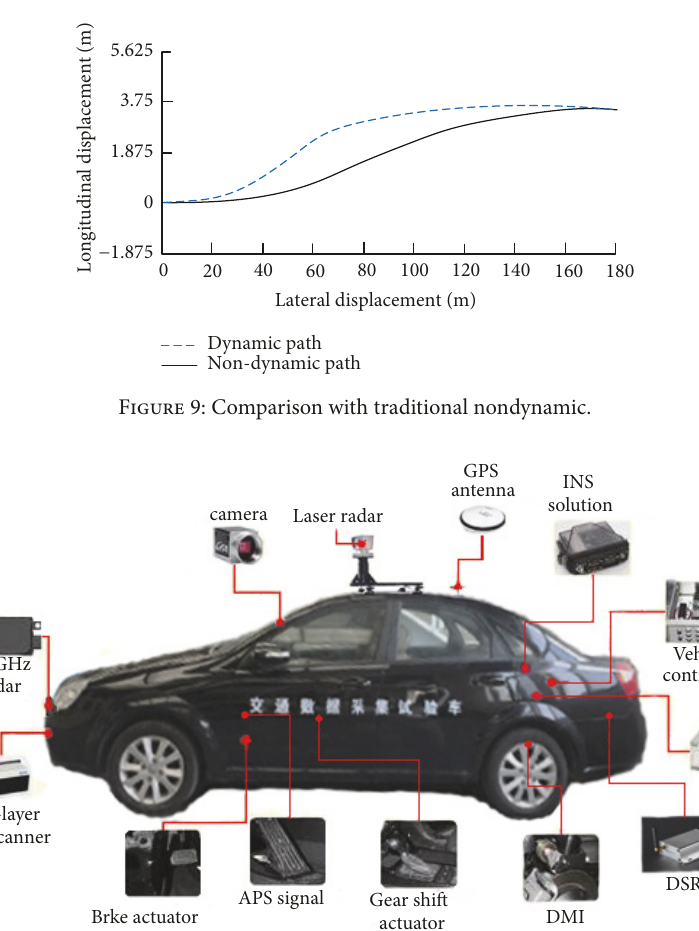
Figure 10: Test vehicles and data acquisition